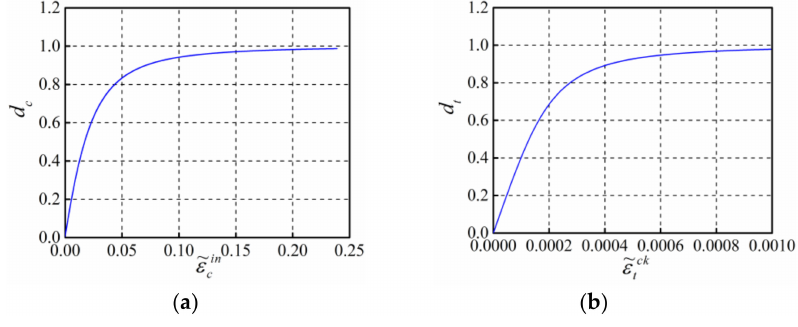
Figure 15. Damage variable curves. ( a ) d c ; and ( b ) d t .